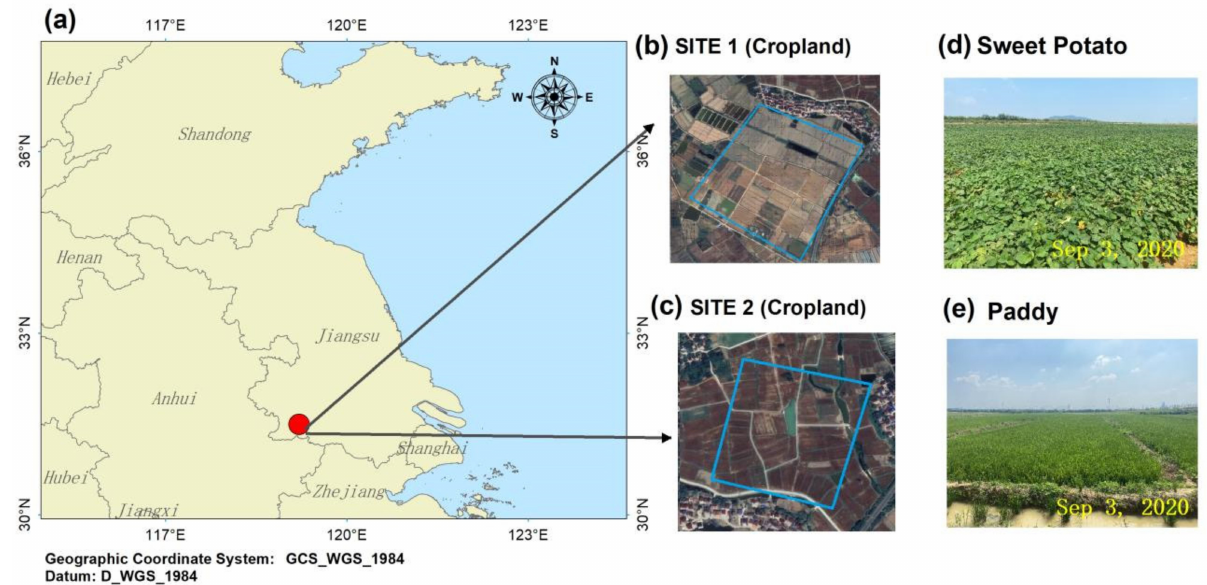
Figure 1. The location ( a ) of the two experimental sites in the study area, ( b , c ) aerial images of two sites from Google Earth, and ( d , e ) photos of main crops at two sites.